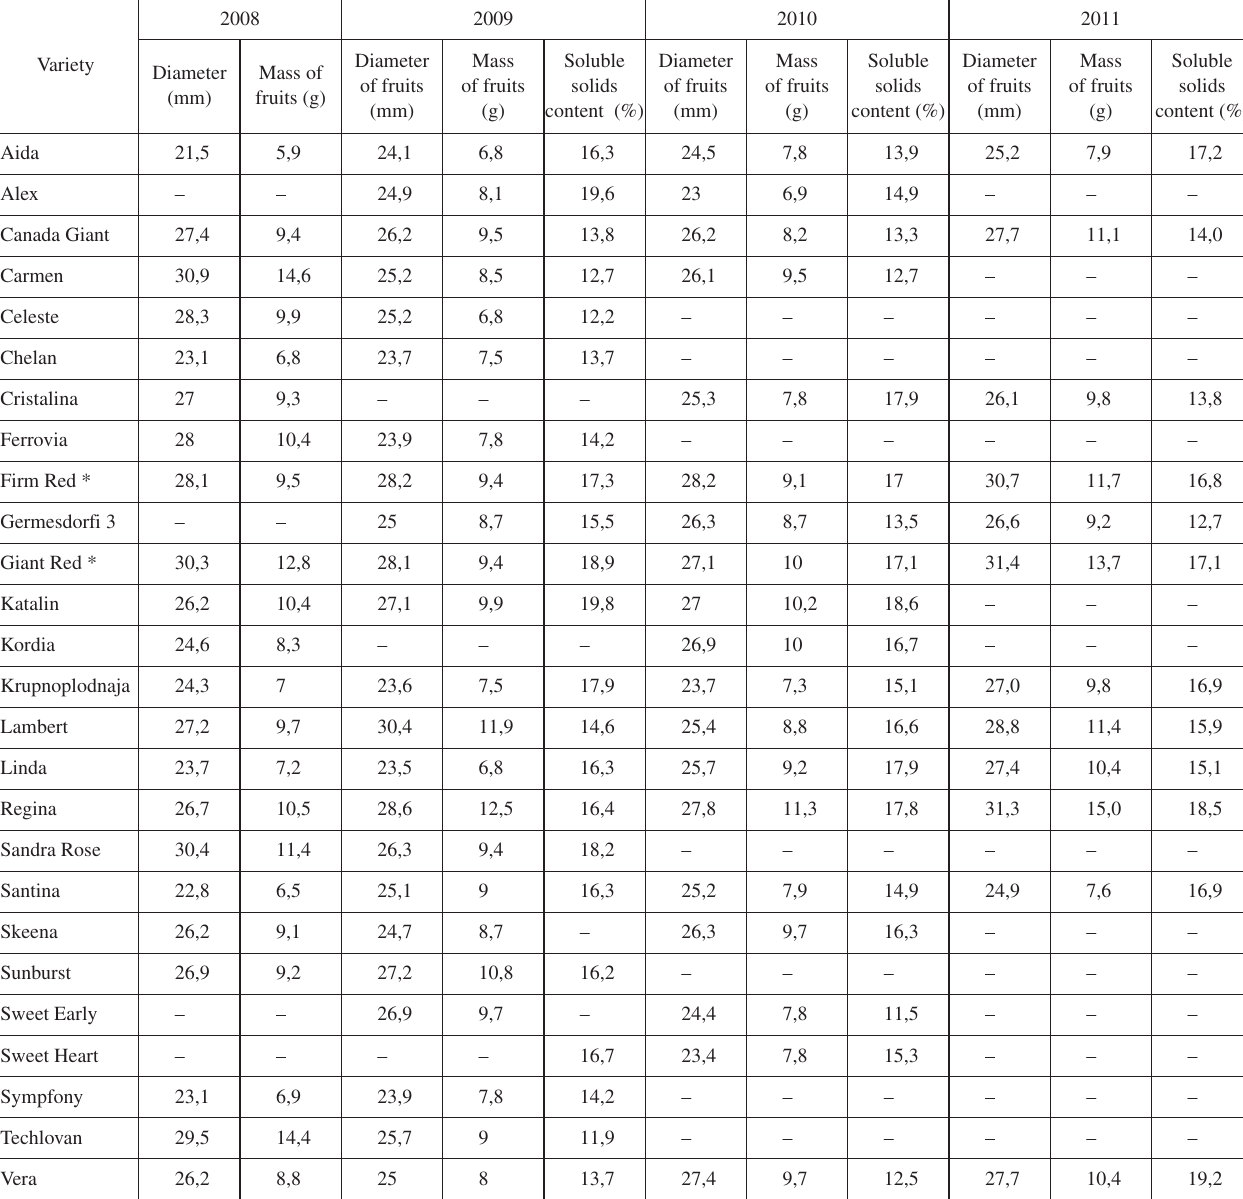
Table 2: Diameter, weigth and soluble solids content of cherry fruits (Nagykutas, 2008–2011)